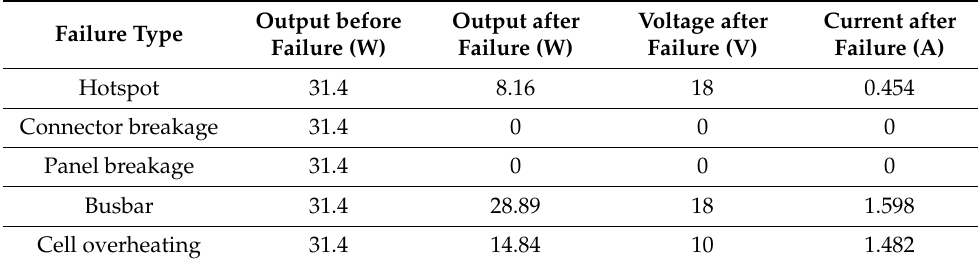
Table 7. Power output of the 35 W PV panel after different failure types.